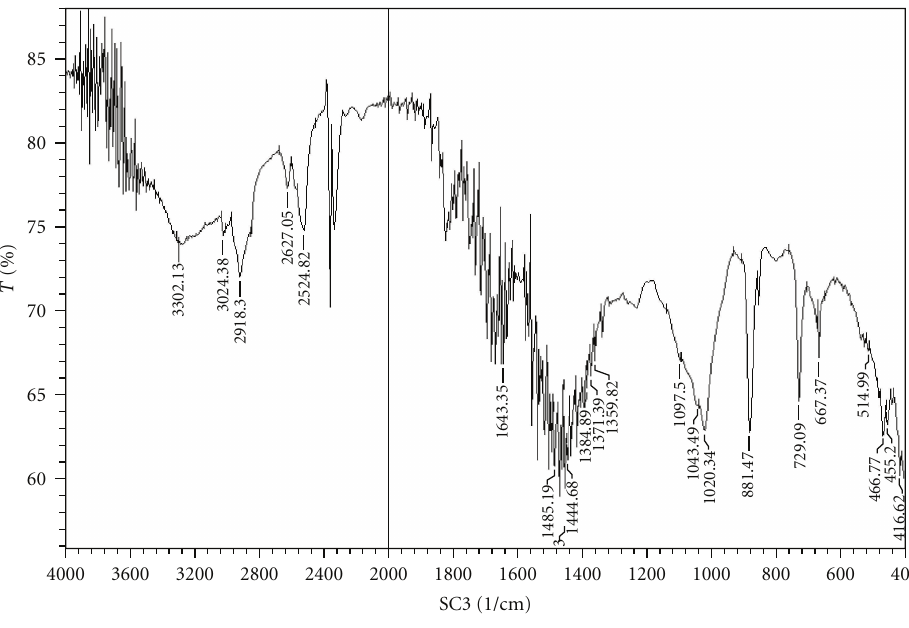
Figure 5: FTIR Spectrum of EPS of Aeromonas hydrophila strain An4.